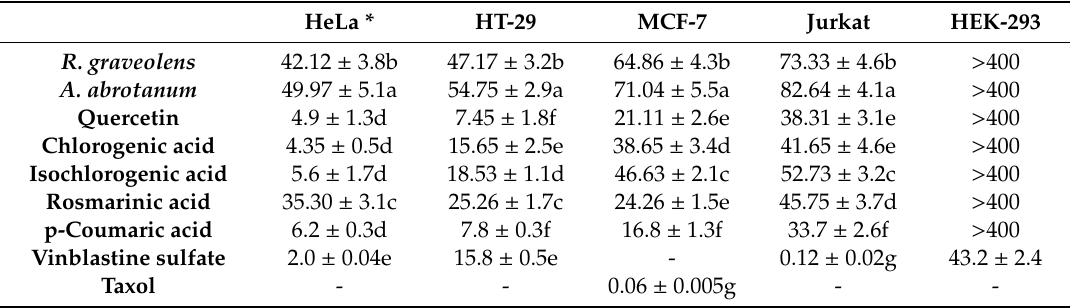
Table 3. Antiproliferative activities of methanolic leaf extracts of Ruta graveolens and Artemisia abrotanum and the identified polyphenols against di ff erent cancer cell